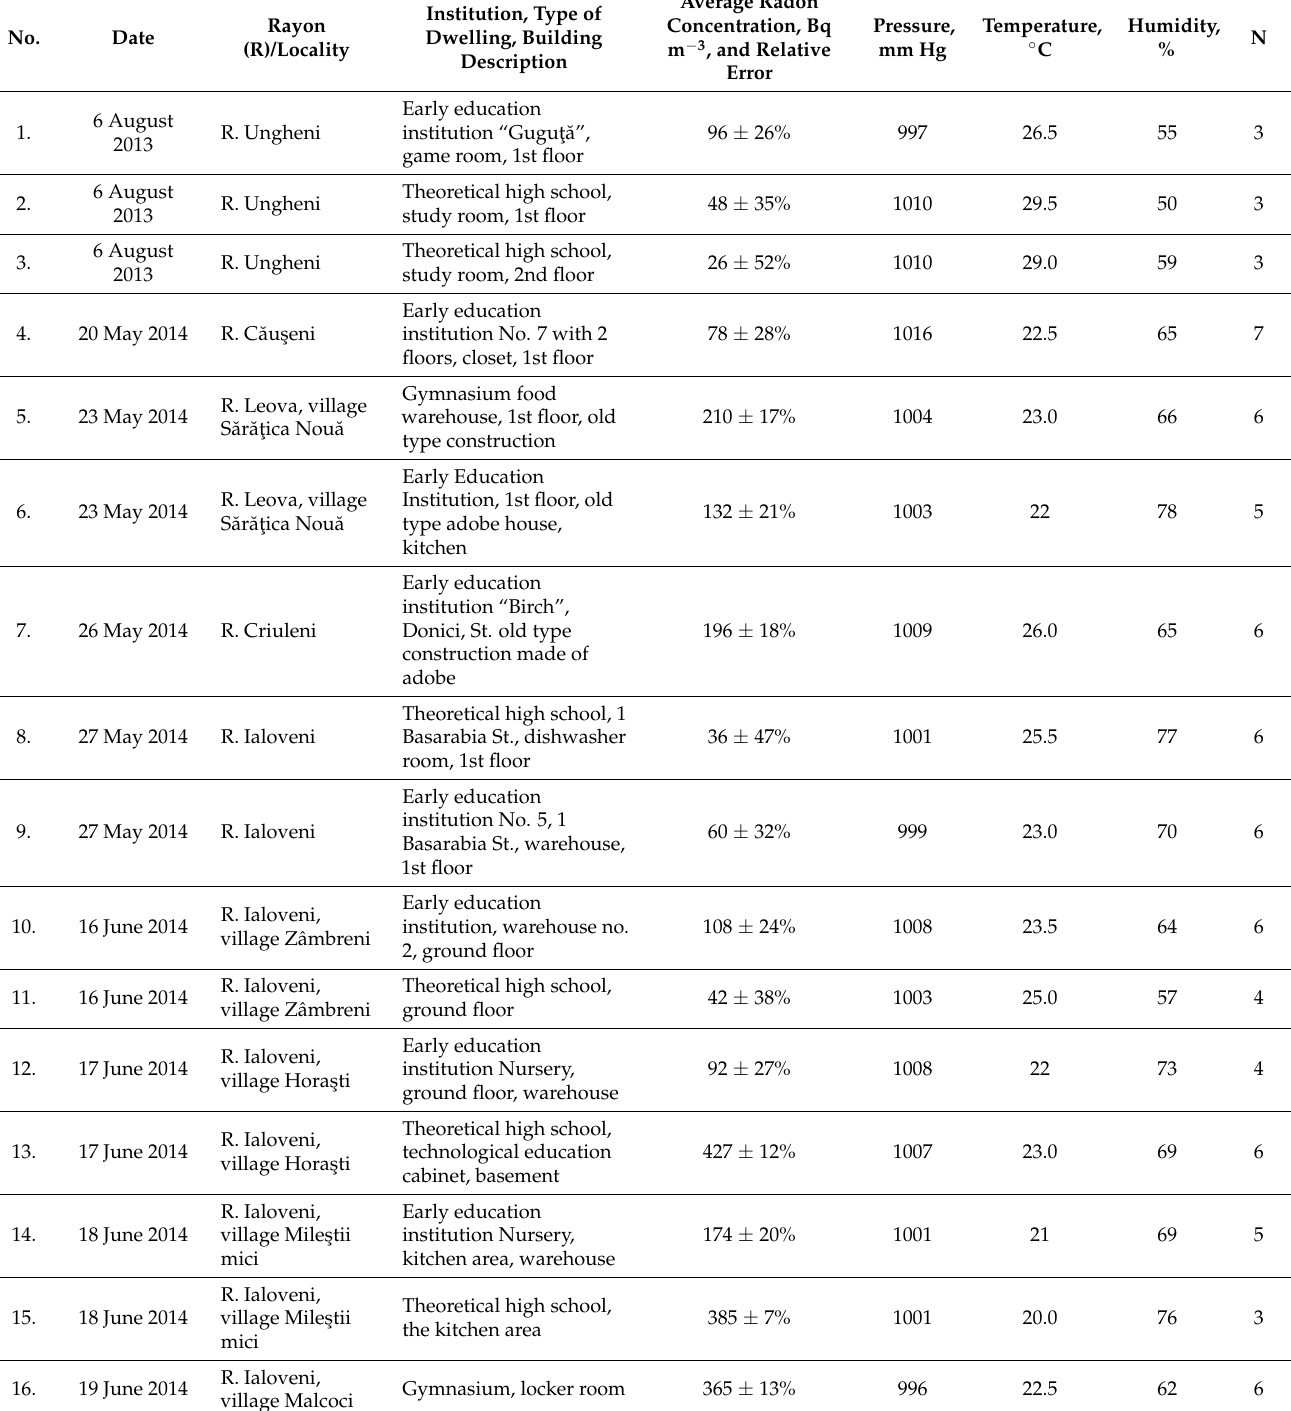
Table A1. The average concentration of radon (Bq m − 3 ) and relative error (%) indicated by the instrument in the indoor air of early education institutions and primary, gymnasium and high school education institutions on the territory of the Republic of Moldova (period 2013–2014, warm time of year) ( n = 29 buildings/N = 149 measurements; working regime of the radonometer: 30